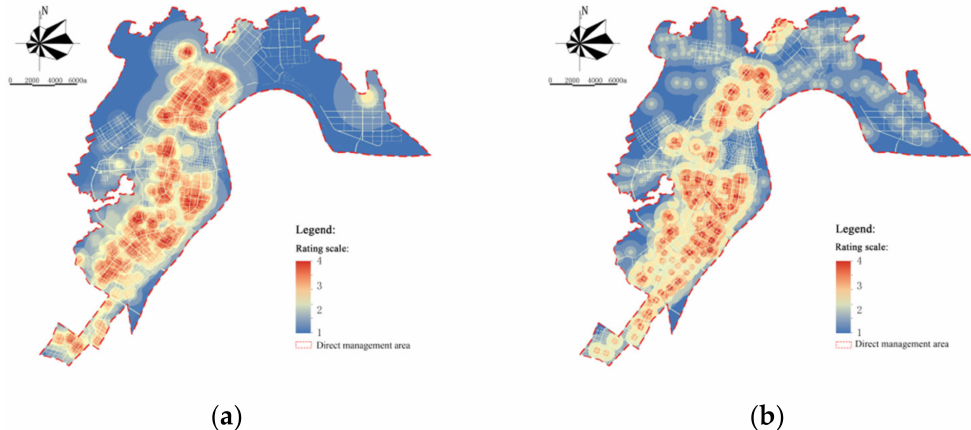
Figure 9. ( a ) Comprehensive assessment diagram of public service facility element; ( b ) Comprehen- sive assessment diagram of public transportation element.